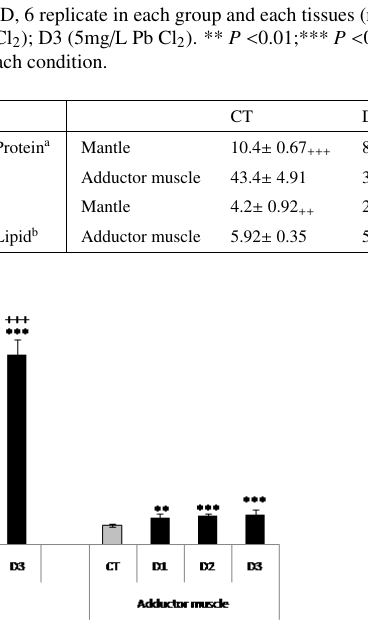
Figure 4. The MT’s levels in the control and treated M. stultorum mantle and adductor muscles with Pb Cl 2 graded doses (D1, D2, D3) during 5 days. Values are expressed as means ± SD, 6 replicate in each group and tissues (n = 3 clams). Pb Cl 2 graded doses: D1 (1mg / L Pb Cl 2 ); D2 (2.5mg / L Pb Cl 2 ); D3 (5mg / L Pb Cl 2 ). ** P < 0.01;*** P < 0.001: Pb Cl 2 groups VS controls for each tissue. +++ P < 0.001: mantle VS adductor muscles for each condition.